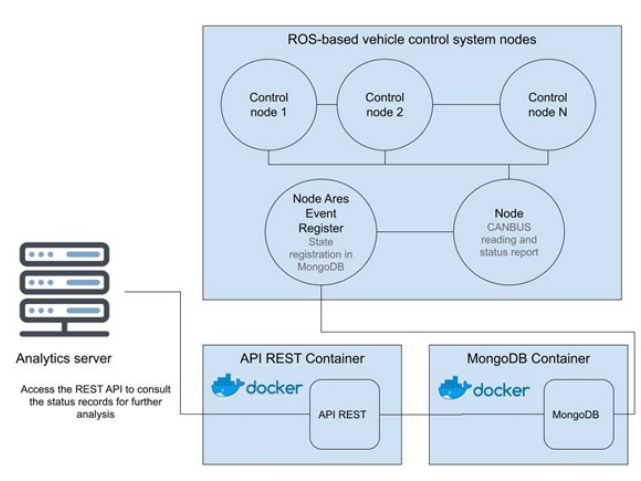
Figure 22. Black box system component